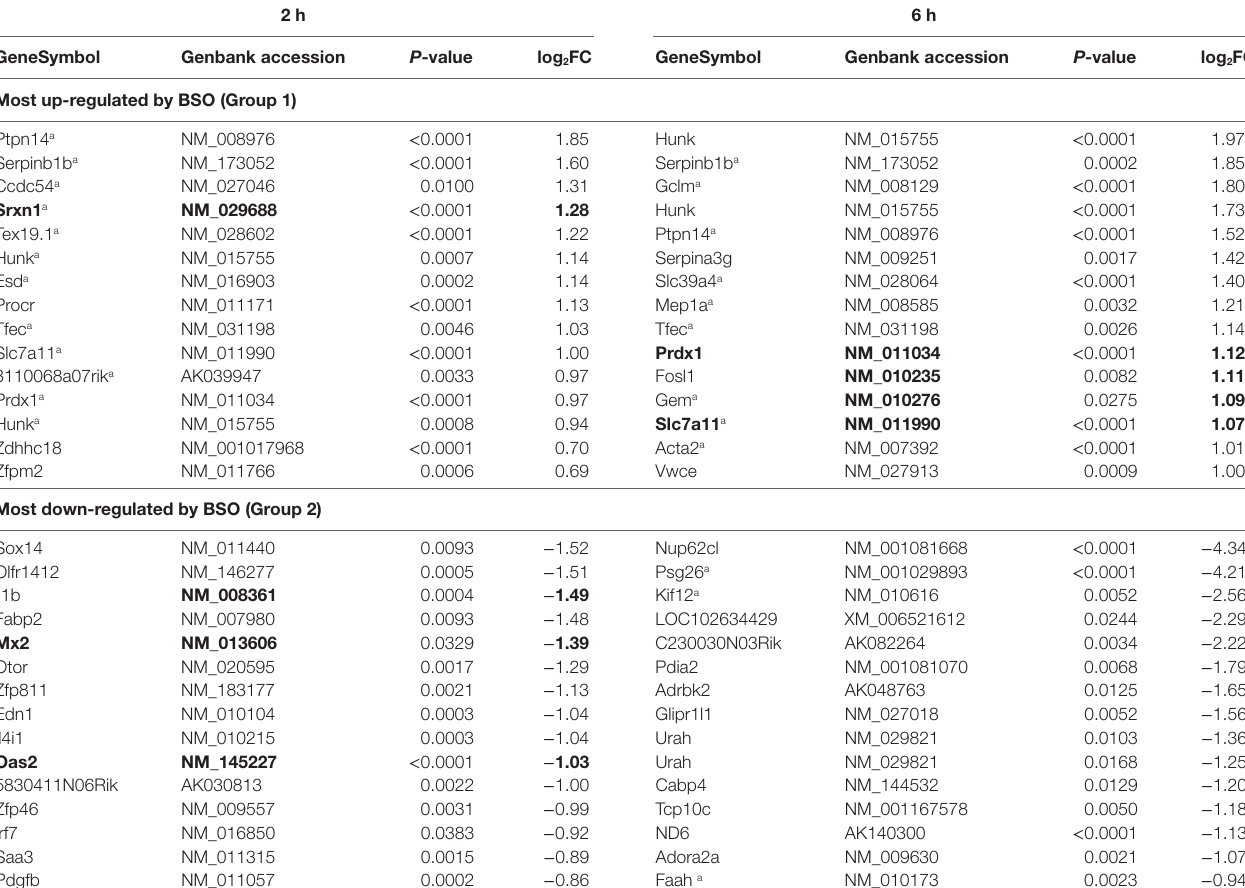
TaBle 1 | LPS-induced transcripts most affected by BSO in Groups 1 and 2. 2